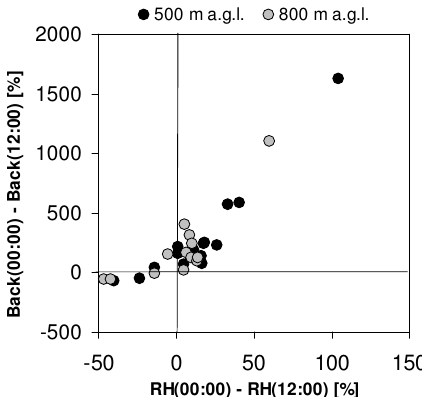
Figure 2 Fig. 2. Relationship between the relative variations [%] in rela- tive humidity (RH) and aerosol backscatter coefficients (Back) be- tween night (00:00UTC) and day (12:00UTC) at 500m a.g.l. and 800m